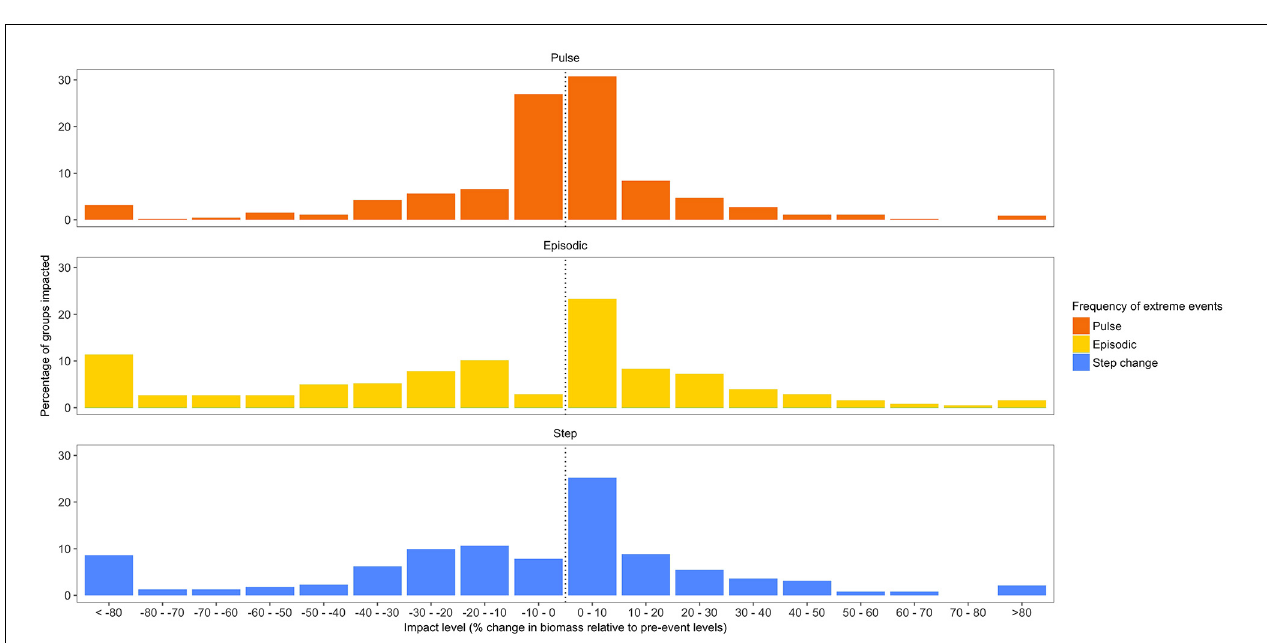
FIGURE 4 | Ecosystem impact plots showing the distribution of percentage change in relative biomass (in comparison to pre-event levels) under the three scenarios: pulsed, episodic, or step-change in the frequency of extreme events (plots aggregate results across all groups in all models).